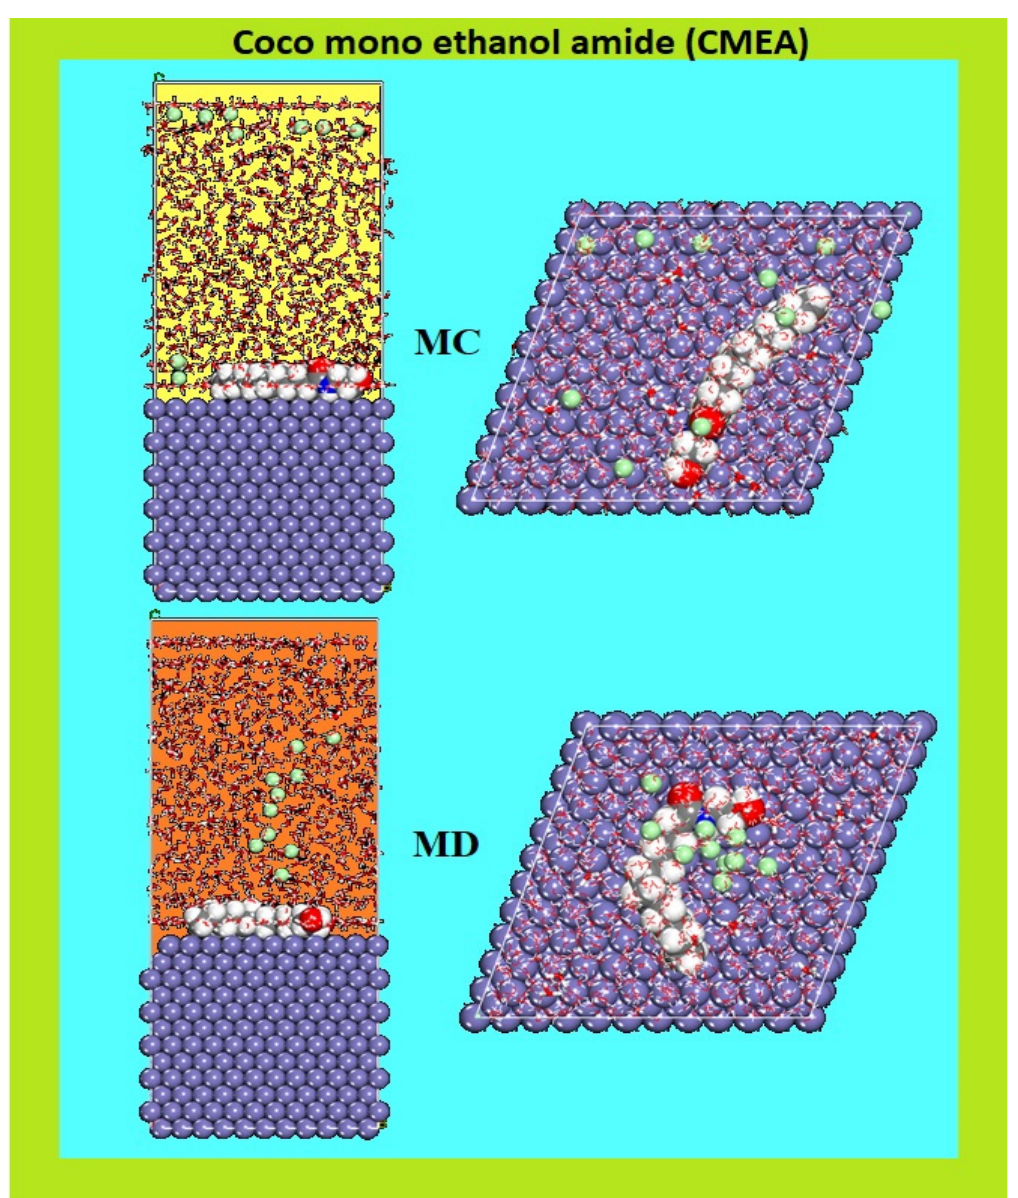
Figure 13. MC and MD attained from the adsorption configurations of the CMEA in the simulated corrosive media on the MS surface.